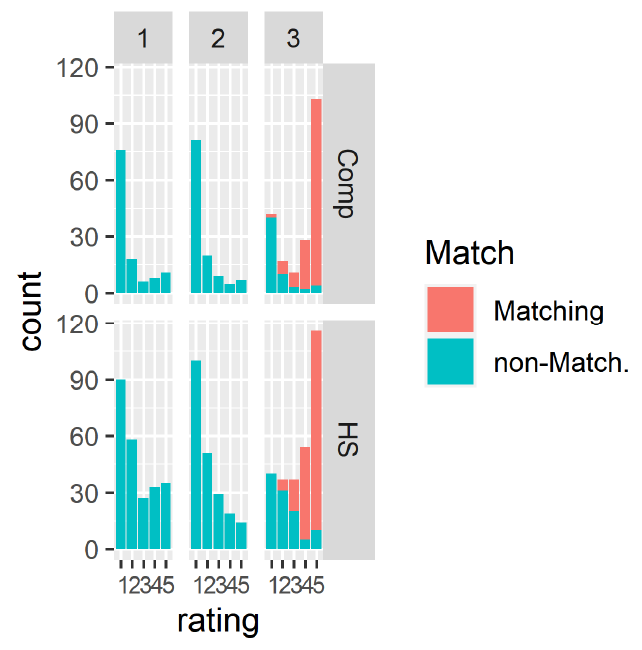
Figure 3. Response counts per person (matching vs. non-matching items).